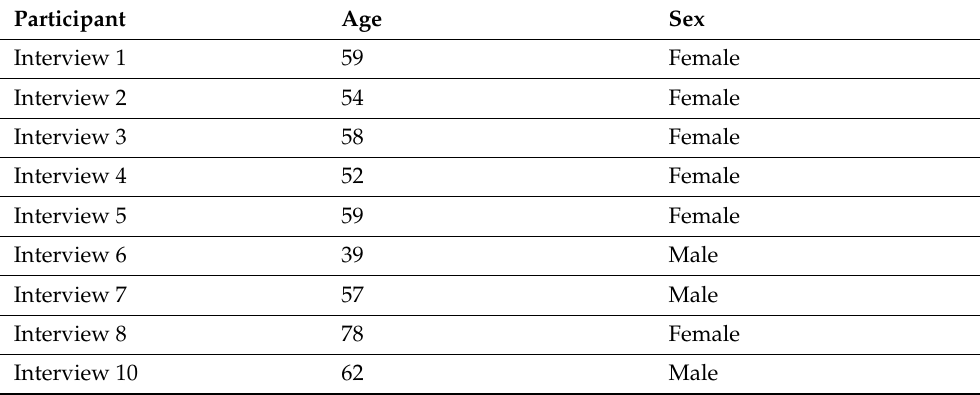
Table 1. Demographic characteristics of the participants. Note that due to a recording error, Interview 1 was not included in the final